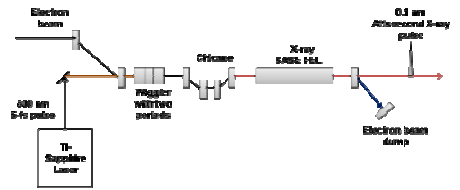
Fig. 1. ESASE scheme for attosecond pulse generation.